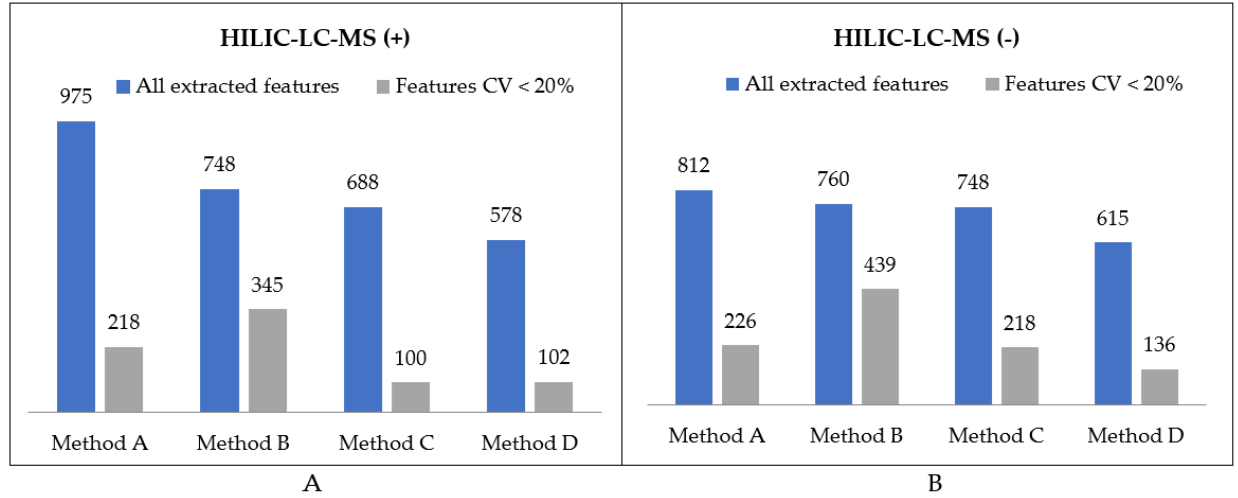
Figure 6. Summary of feature numbers detected in polar extracts using HILIC-LC-MS in ( A ) positive and ( B ) negative MS ionization modes.